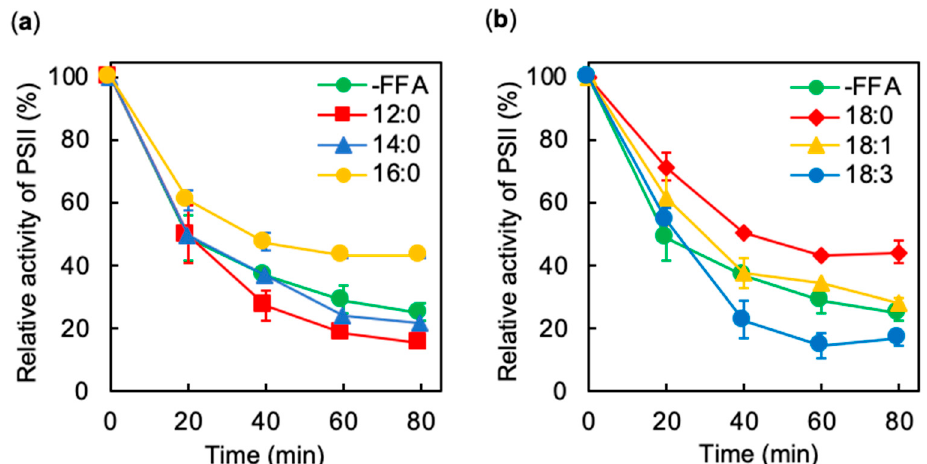
Figure 1. Photoinhibition of PSII in Synechocystis cells under strong light in the presence of various free fatty acids (FFA). ( a ) Synechocystis cells were incubated at 32 °C under strong light at 1500 μ mol photons m − 2 s − 1 , with ambient aeration, in the absence (-FFA); green circles or presence of 0.1 mM lauric acid (12:0); red squares, myristic acid (14:0); blue triangles, or palmitic acid (16:0); yellow circles. ( b ) Same condition as (a) in the absence (-FFA); green circles or presence of 0.1 mM stearic acid (18:0); red diamonds, oleic acid (18:1); yellow triangles, and α -linolenic acid (18:3); blue circles. The activity of PSII of the cells was measured at 32 °C in terms of the evolution of oxygen in the presence of 1 mM 1,4-benzoquinone and 1 mM K 3 Fe(CN) 6 . Values are means ± S.D. (bars) of results from three independent experiments.